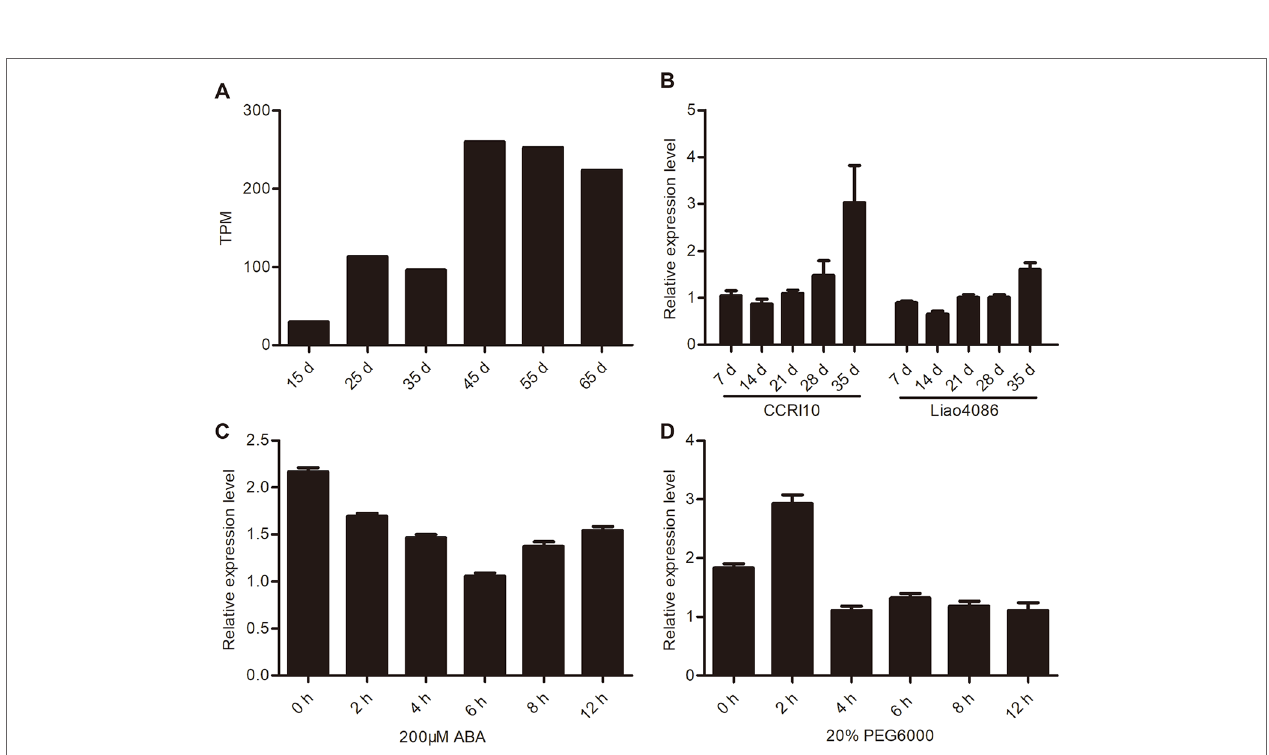
FIGURe 3 | Expression patterns of GhWRKY91 during leaf senescence and under stress treatments. (a) Expression profiles of GhWRKY91 in 15-, 25-, 35-, 45-, 55-, and 65-day-old CCRI36 cotton leaves using the transcriptome data (Lin et al., 2015). TPM, transcripts per million clean tags. (B) Transcript levels of GhWRKY91 at different stages of leaf senescence in CCRI10 and Liao4086 varieties. (C – D) Transcript levels of GhWRKY91 under ABA and PEG6000 treatments. GhActin served as the reference gene. The data are the means ± standard errors (SEs) of three biological